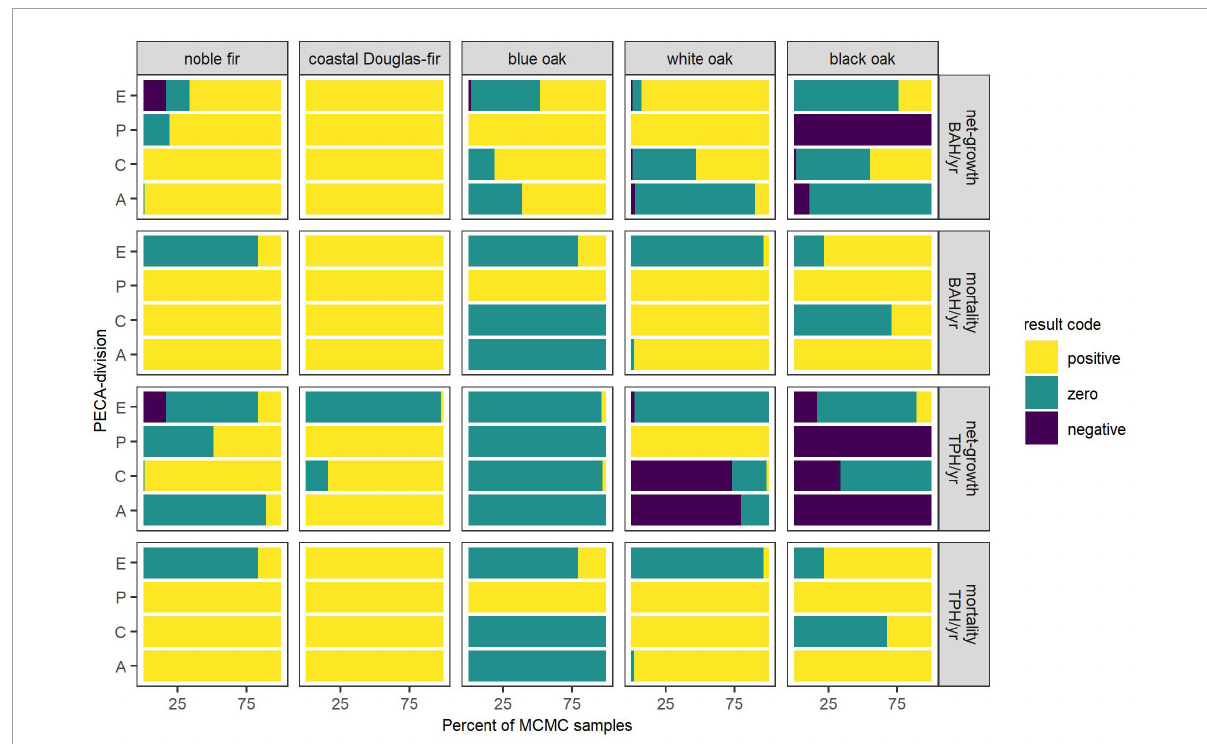
FIGURE4 For each species and PECA-division under the RCP 4.5 CCSM4 (mildest) scenario, the percent of MCMC samples for which equal-tailed 90% confidence intervals for estimates of net-growth and mortality, in terms of BAH/year or TPH/year, were classified as positive (lower bound of interval greater than zero), zero (zero within interval), or negative (upper bound of interval less than zero). Per-ha estimates are for forest land where the species was present within the PECA-divisions, that is, areas of projected expansion (E), persistence (P), contraction (C), and where habitat was projected to remain climatically unsuitable (A). Percentages are based on MCMC samples for which an estimate was